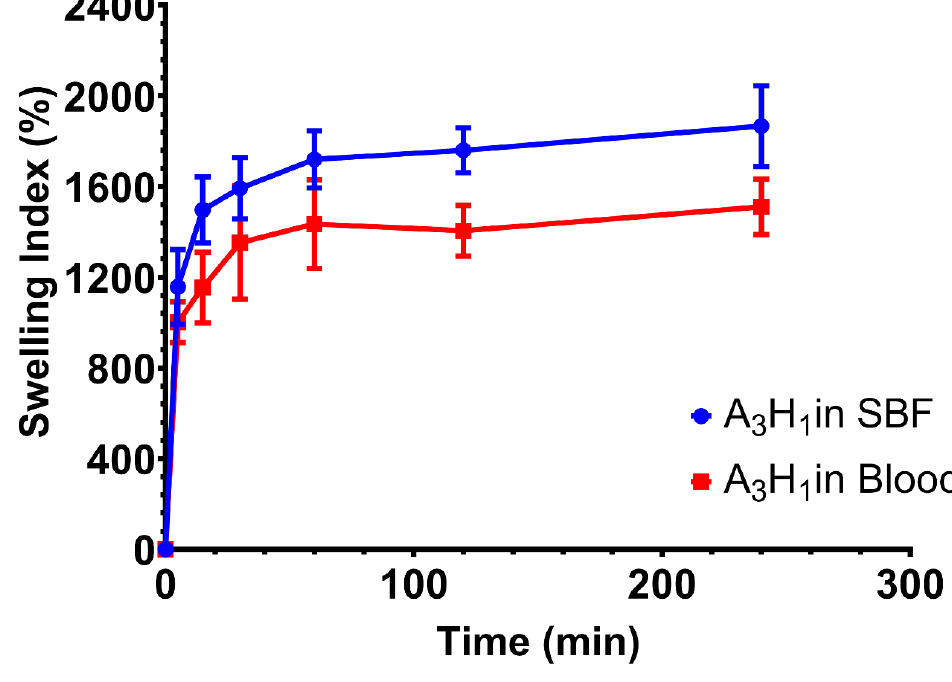
Figure 7. Swelling profile of A 3 H 1 aerogel in simulated body fluid and blood.